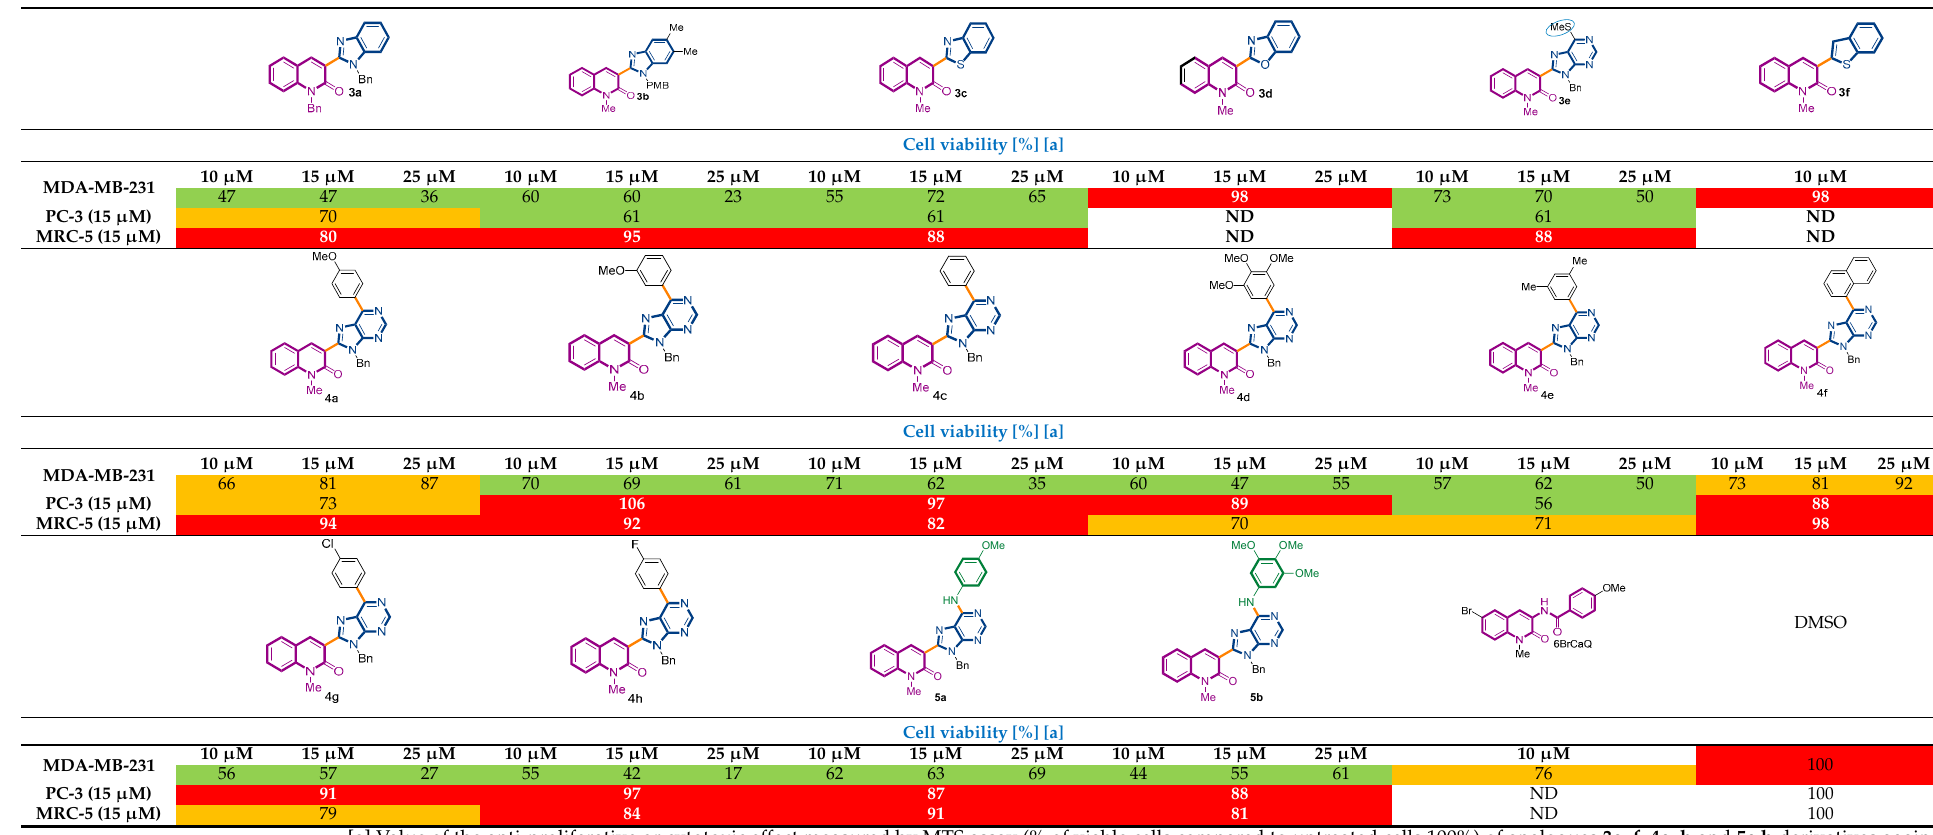
Table 1. Cell viability effect of 3a–f , 4a–h and 5a , b derivatives against MDA-MB-231, PC-3 and MRC-5 cell lines measured through cell metabolic activity